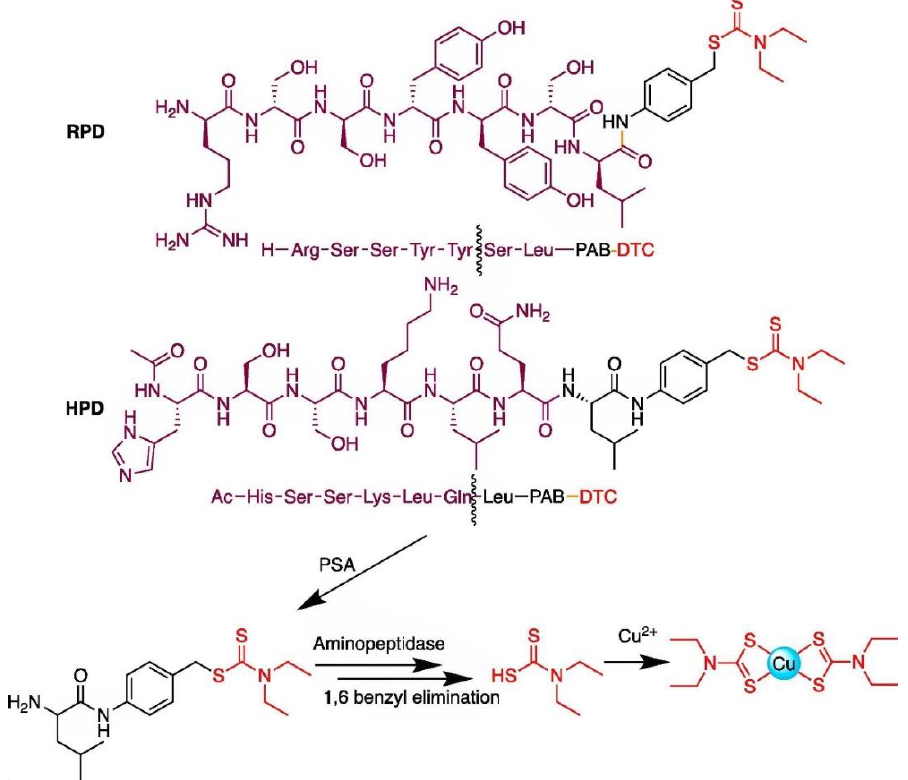
Figure 27. Chemical structures of prodrugs and the reaction scheme to the formation of [Cu(S 2 CNEt 2 ) 2 ] via PSA-induced cleavage and amino acid trimming activity of non-specific aminopeptidases. Reproduced with permission from [271]. Copyright 2020 Elsevier.